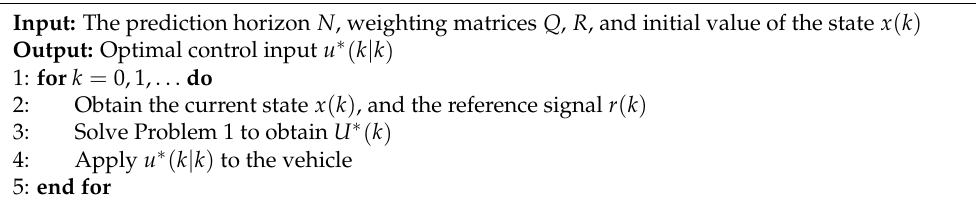
Algorithm 1 NMPC of automated